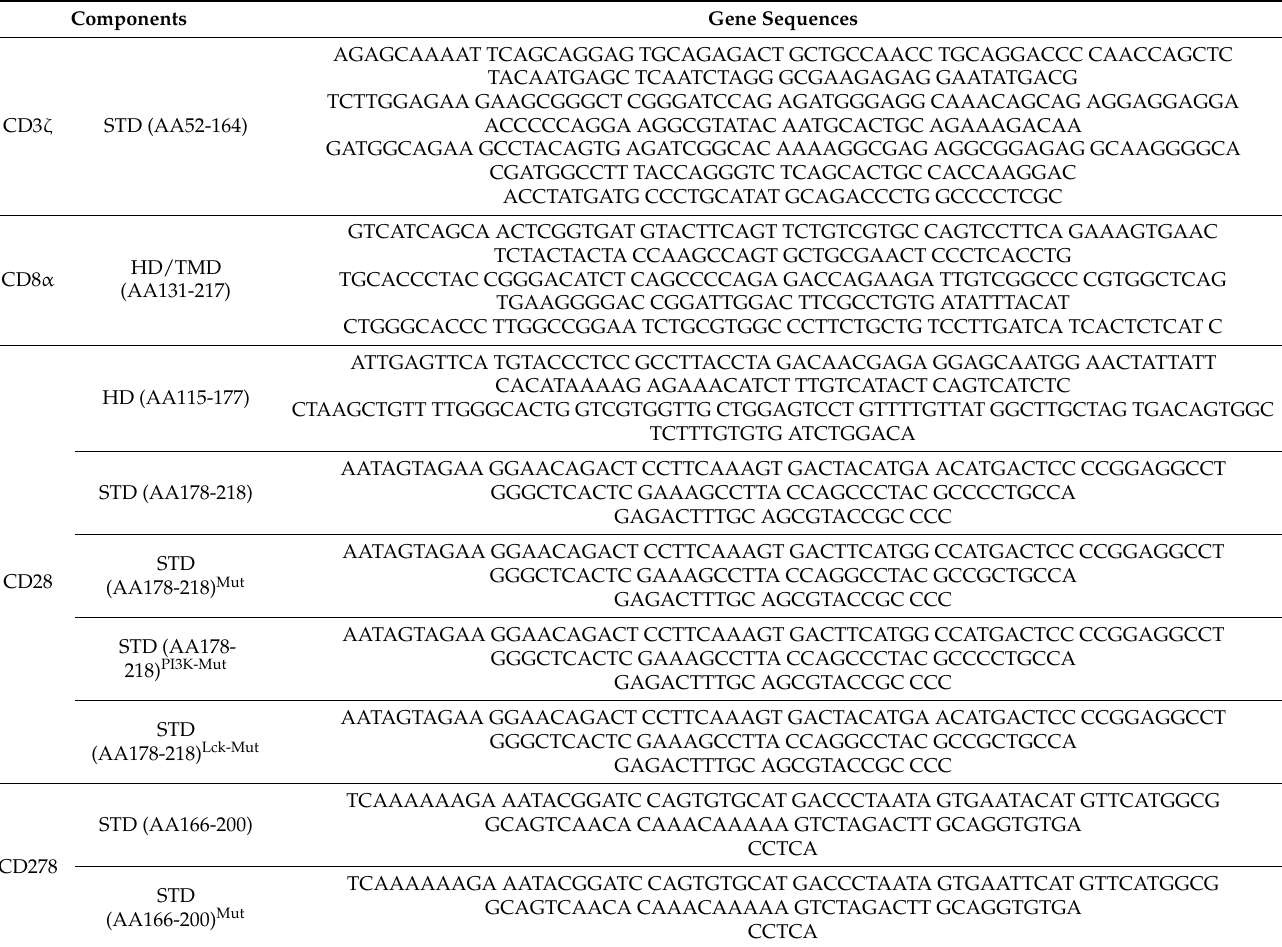
Table 1. Gene sequences of the immune molecules used as CAR components in this study. Components Gene